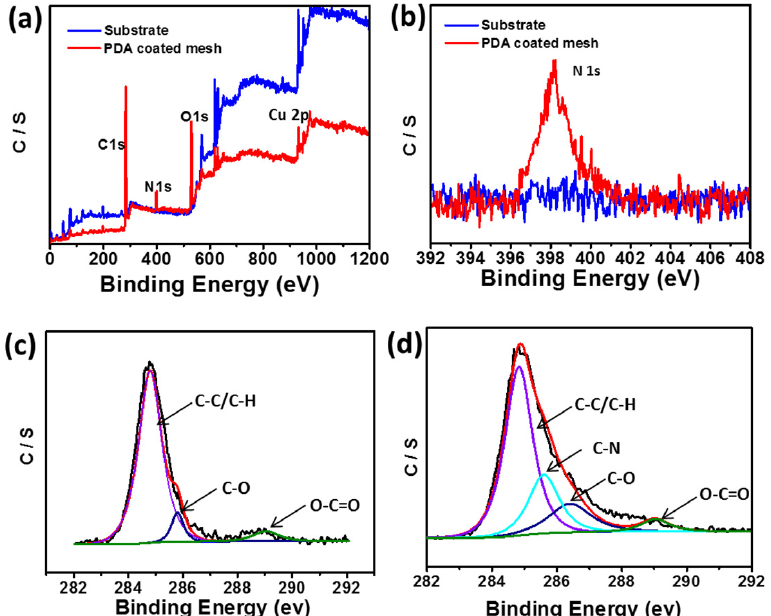
Figure 3. XPS spectra of the as-prepared mesh: ( a ) Survey scans of the spectral region from 0 to 1200 eV. ( b ) High-resolution XPS N1s narrow scans as a function of electron binding energy (BE). High-resolution XPS spectra of C1s peaks for ( c ) ETCu/20 and ( d ) PDA60/ETCu.